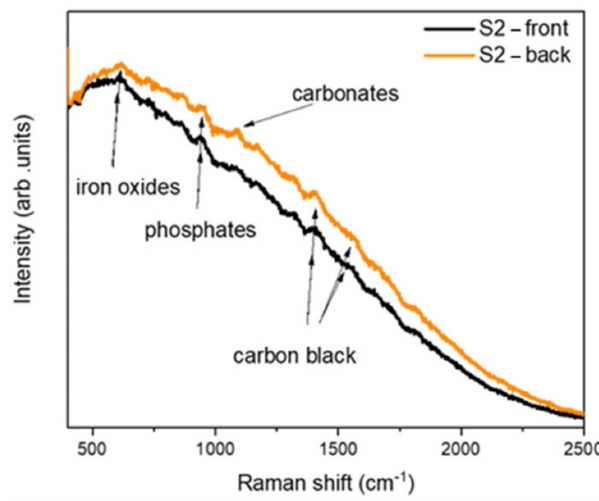
Figure 3. Representative Raman spectra, in the 400 − 2500 cm − 1 region, recorded on the front and back sides of sample